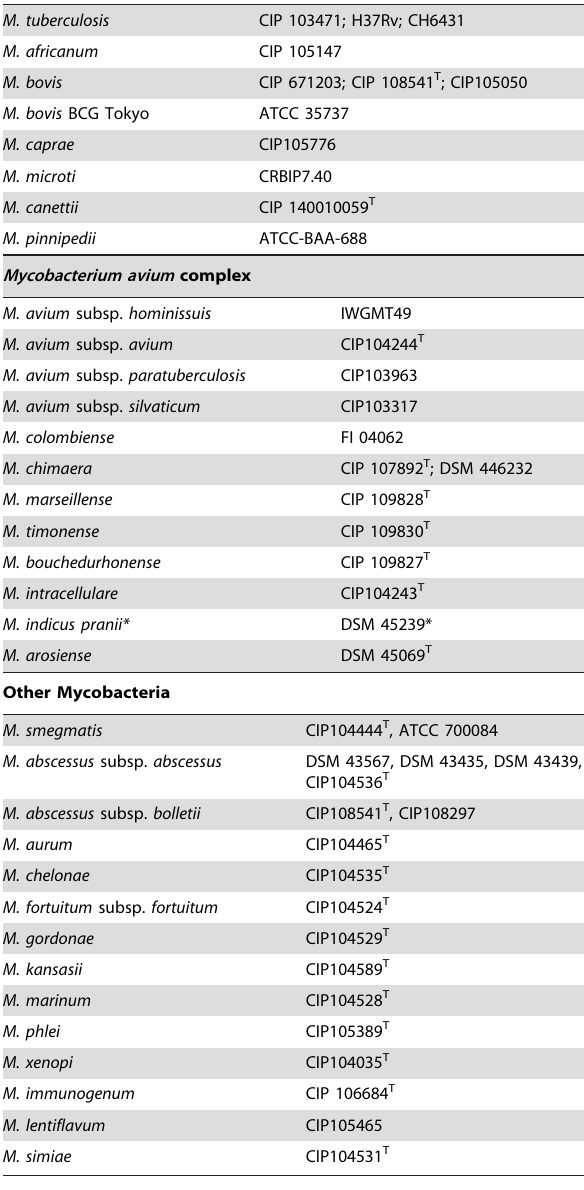
solution; absolute ethanol for protein precipitation (Table 2,